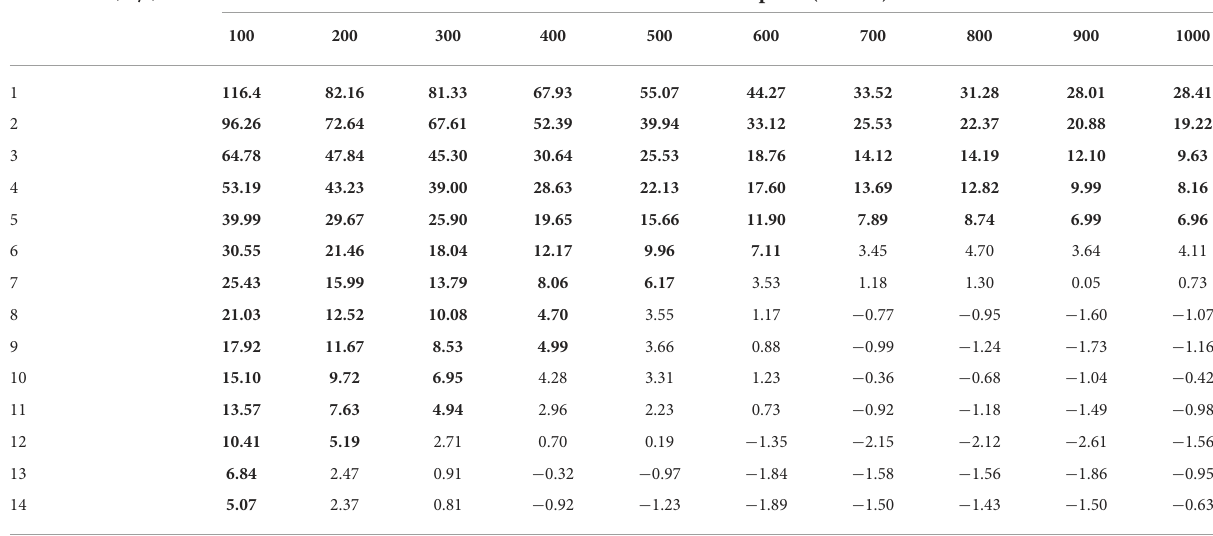
TABLE 1 The strength of spatial-temporal clustering (S) of all case pairs from May to June 2021 in Guangzhou, China. Time interval(days) Distance between case pairs